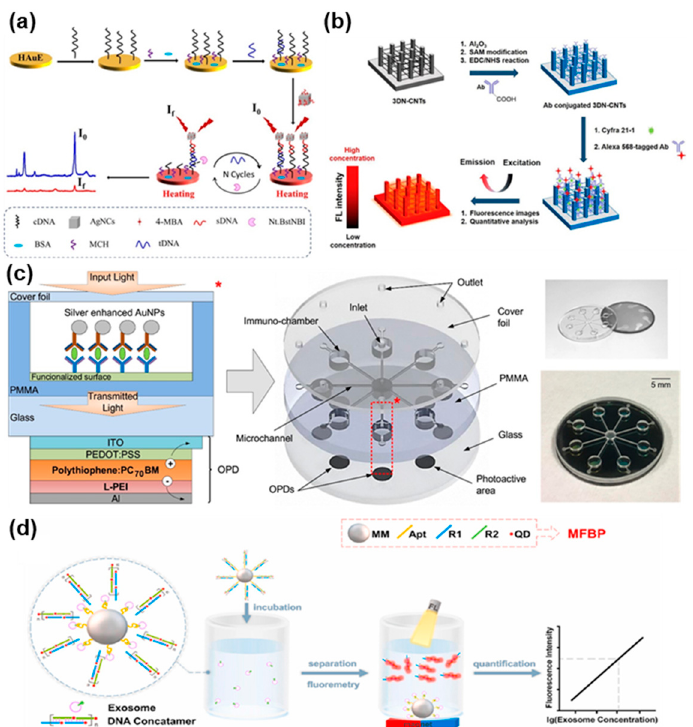
Figure 7. Summary of recently developed optical biosensors for the detection of oral cancer biomarkers in saliva ( a ) SERS-based optical DNA biosensor. Reprinted with permission from ref. [100]. Copyright 2021 Elsevier. ( b ) Fluorescence immunosensor based on 3DN-CNTs for the detection of Cyfra21.1. Reprinted with permission from ref. [124]. Copyright 2018 Elsevier. ( c ) Absorbance-based biosensor with integrated microfluidic channels and antibody-functionalized detection chambers. Reprinted with permission from ref. [127]. Copyright 2017 Elsevier. ( d ) Detection of salivary exosomes through magnetic and fluorescent bio-probes for the non-invasive diagnosis of oral cancer. Reprinted with permission from ref. [110]. Copyright 2021 Elsevier.